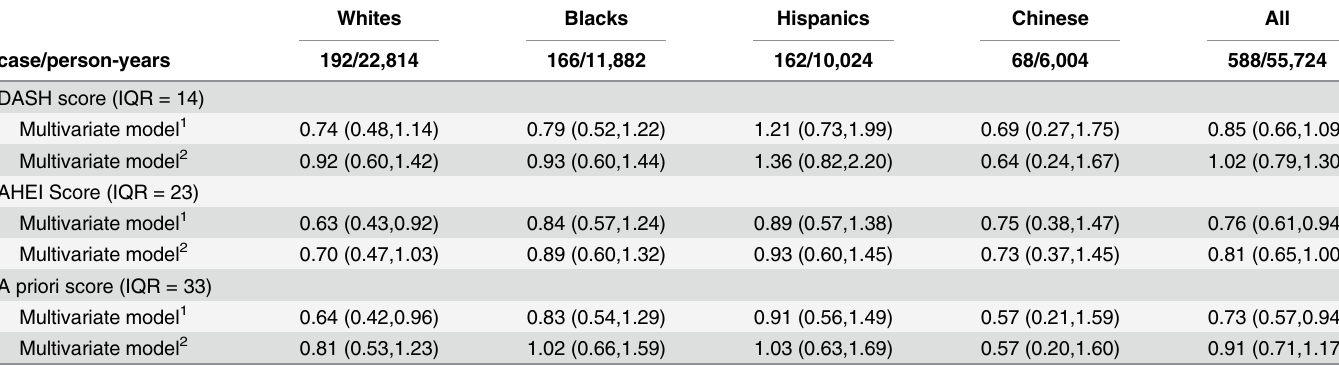
Table 4. HRs (95% CIs) of type II diabetes per 1-interquintile rage (IQR) unit of diet quality scores in 5,160 U.S. adults. Whites Blacks Hispanics Chinese All